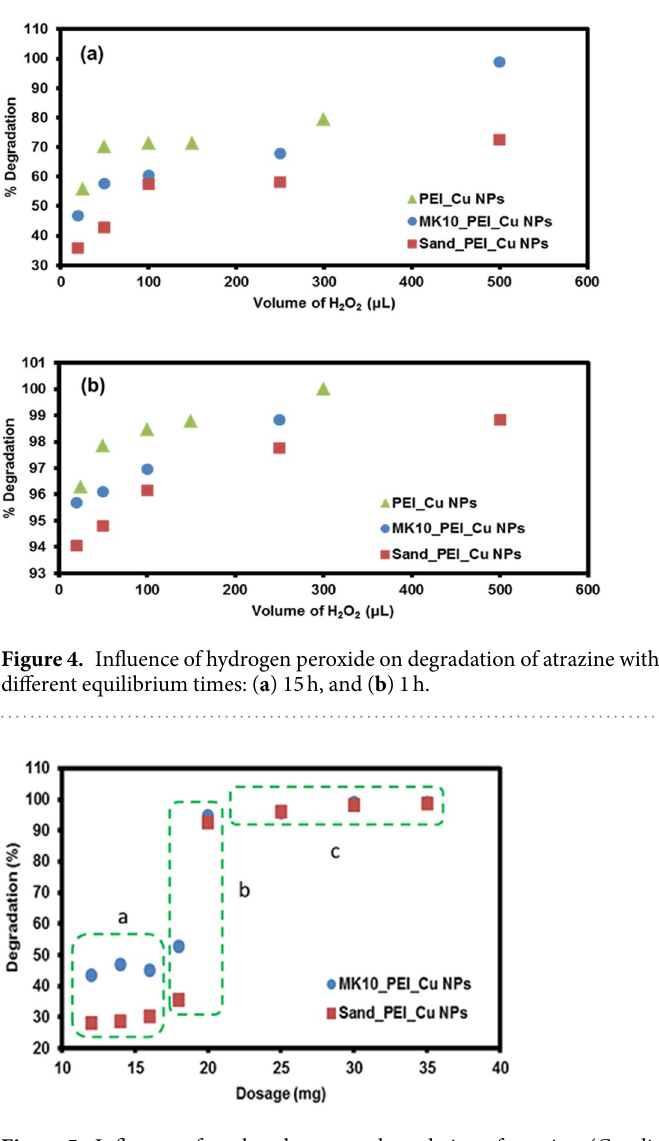
6 Scientific RepoRts | 7: 1415 | DOI:10.1038/s41598-017-01429-5